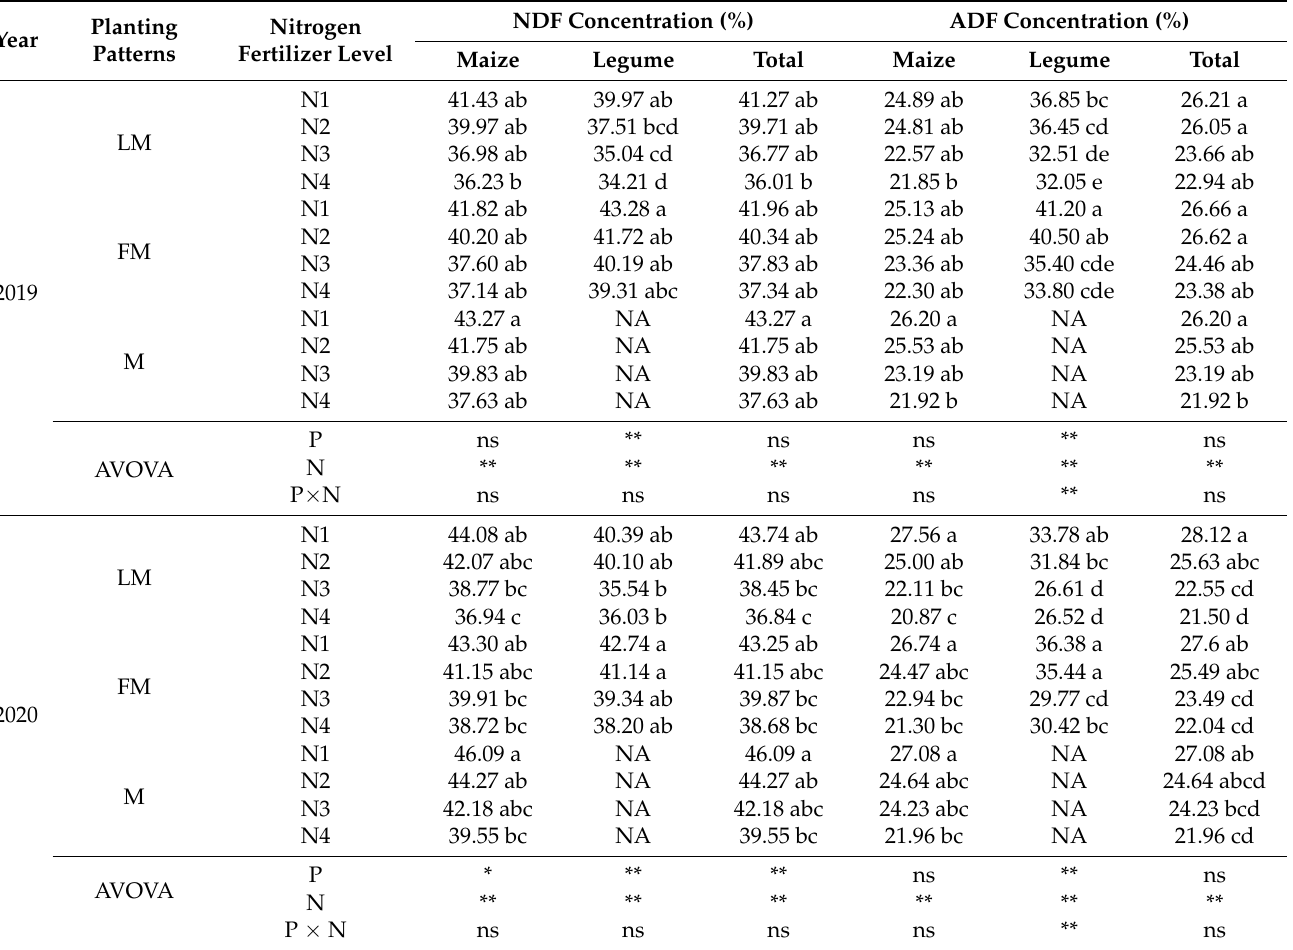
Table 2. Acid detergent fiber (ADF) and neutral detergent fiber (NDF) concentration of silage maize and leguminous crops under different treatments in 2019 and 2020